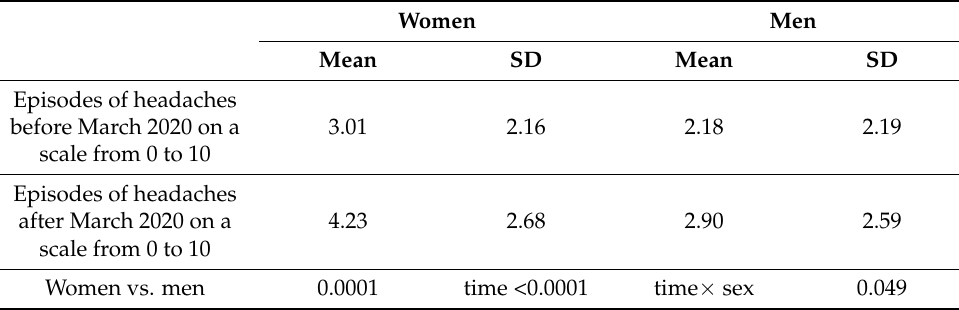
Table 4. Headache episodes among dentists before and during the